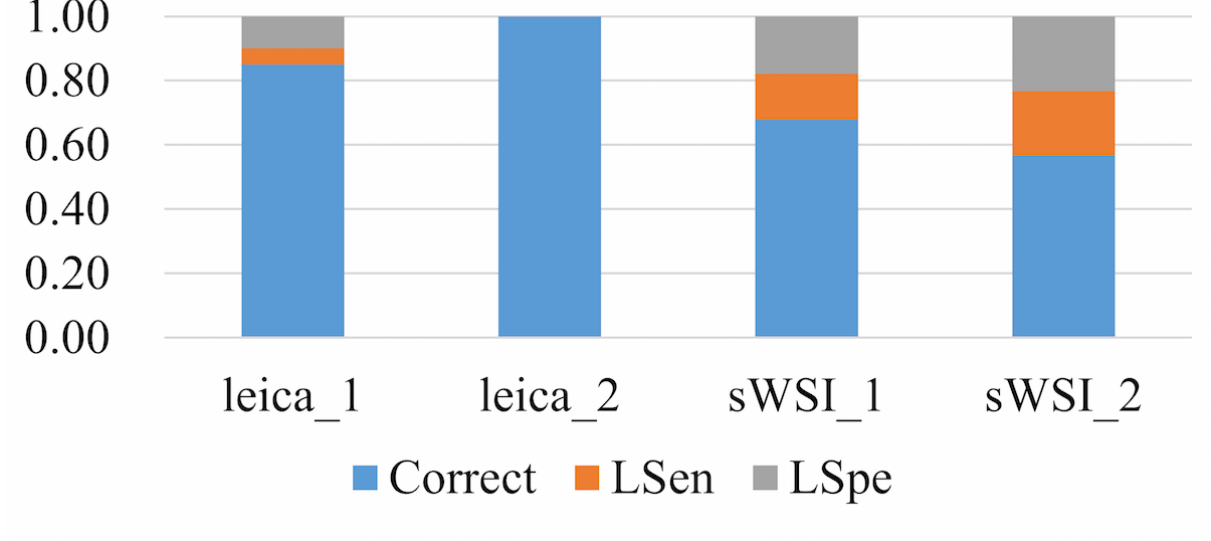
Figure 11. Performance based on scanner and sWSI virtual slides. Sample type: lung. LSen: low sensitivity; LSpe: low